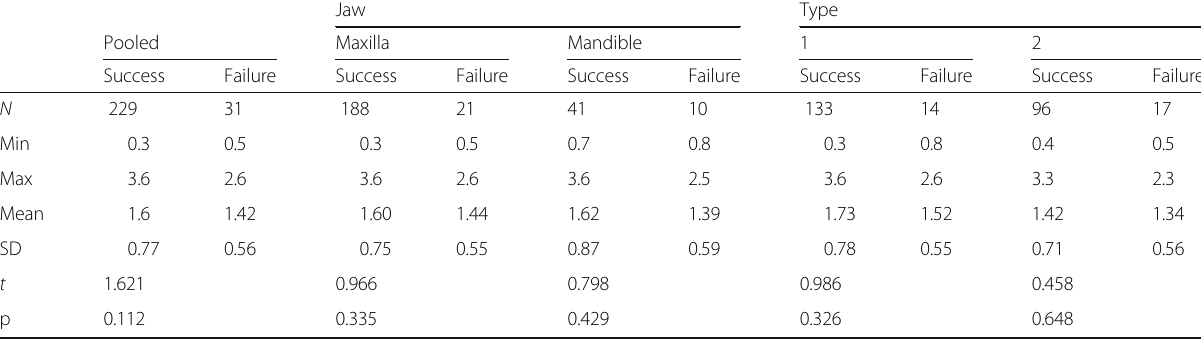
Table 2 Comparison of DT distance (mm) between the two groups in the pooled sample, in each jaw separately and by mini- implant